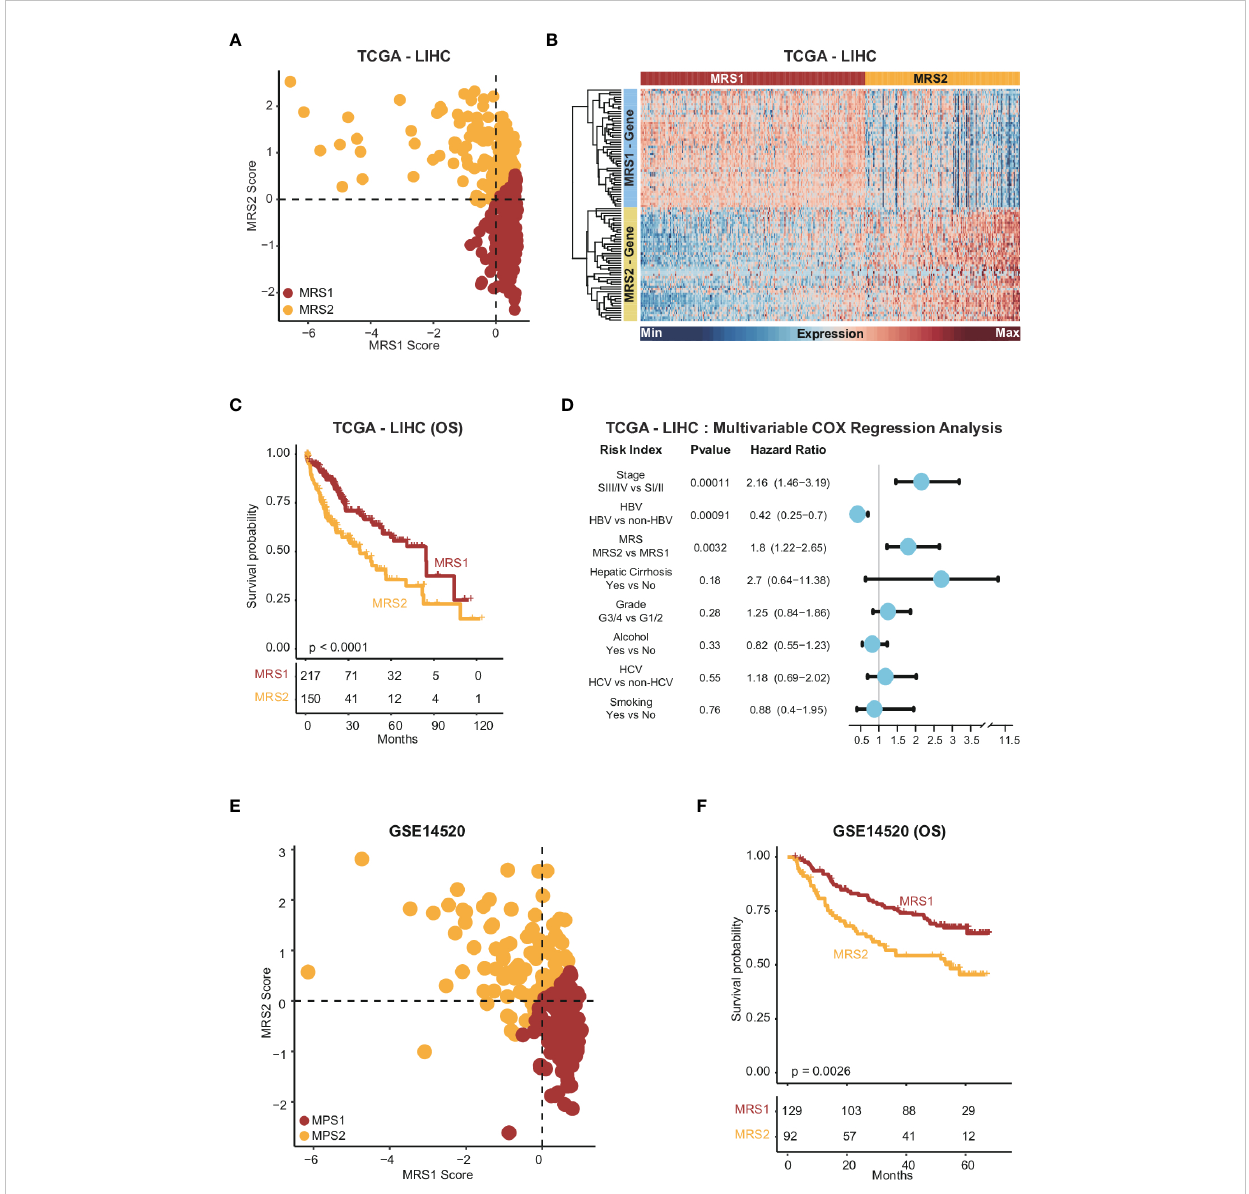
FIGURE 3 Strati fi cation of HCC samples based on the expression of MRS1 and MRS2 genes (A) Scatter plot showing enrichment scores of MRS1 genes (x-axis) and MRS2 genes (y-axis) in each sample in TCGA-LIHC cohort. Metabolic subgroups were assigned based on the enrichment scores of MRS1 and MRS2 genes (see "Methods"). (B) Heatmap showing the co-expressed MRS1 and MRS2 genes in two metabolic subgroups in TCGA-LIHC cohort. (C) Kaplan-Meier curves showing the OS of HCC patients with MRS1 or MRS2 phenotype in TCGA-LIHC cohort. (D) Multivariate COX regression analysis of metabolic subtypes and clinical characteristics in TCGA-LIHC cohort. (E) Scatter plot showing enrichment scores of MRS1 genes (x-axis) and MRS2 genes (y-axis) in each sample in GSE14520 cohort. Metabolic subgroups were assigned based on the enrichment scores of MRS1 and MRS2 genes (see "Methods"). (F) Kaplan-Meier curves showing OS of HCC patients with MRS1 or MRS2 phenotype in GSE14520